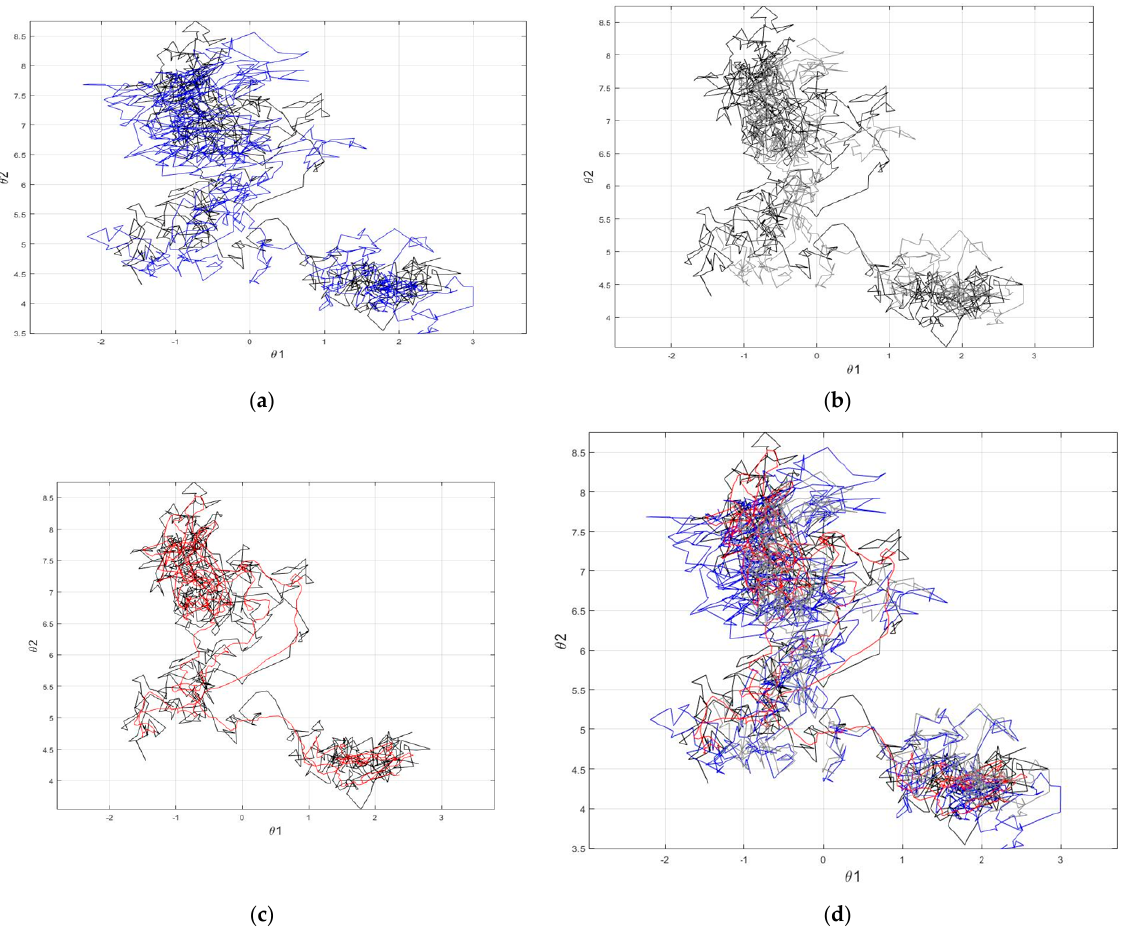
Figure 6. Tracking path predicted by different UAV tracking methodologies: ( a ) real drone path vs. DMK, ( b ) real drone path vs. PF, ( c ) real drone path vs. UEAKF, ( d ): UEAKF, DMK, and PF vs. real drone path.